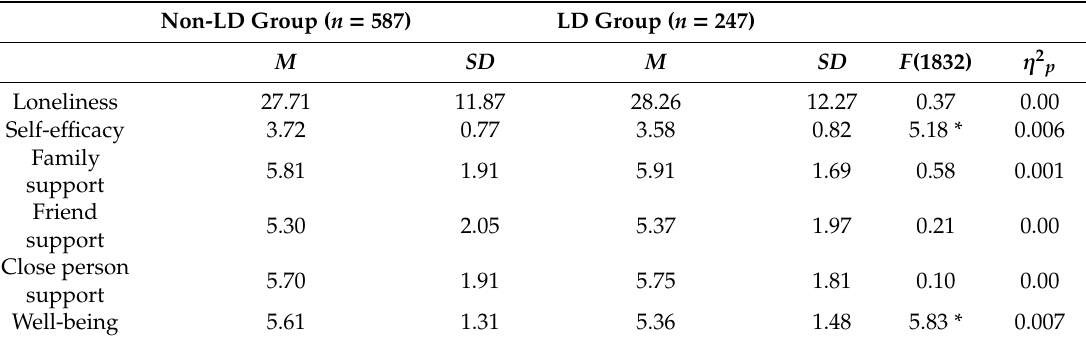
Table 1. Multivariate analysis of variance for observed indicators.